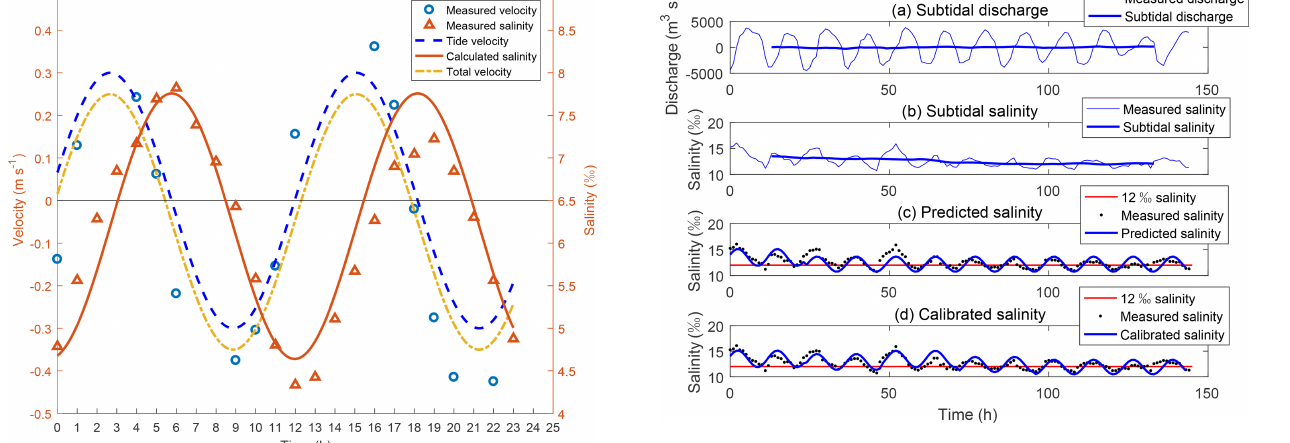
Figure 12. Time for water intake of given salinity that is higher than 12‰. (a) Slight changes of the subtidal discharge. (b) Decreasing trend of subtidal salinity. (c) Predicted salinity on the basis of ob- served data on 29 January. (d) Calibrated salinity on the basis of observed data from 29 January to 3 February